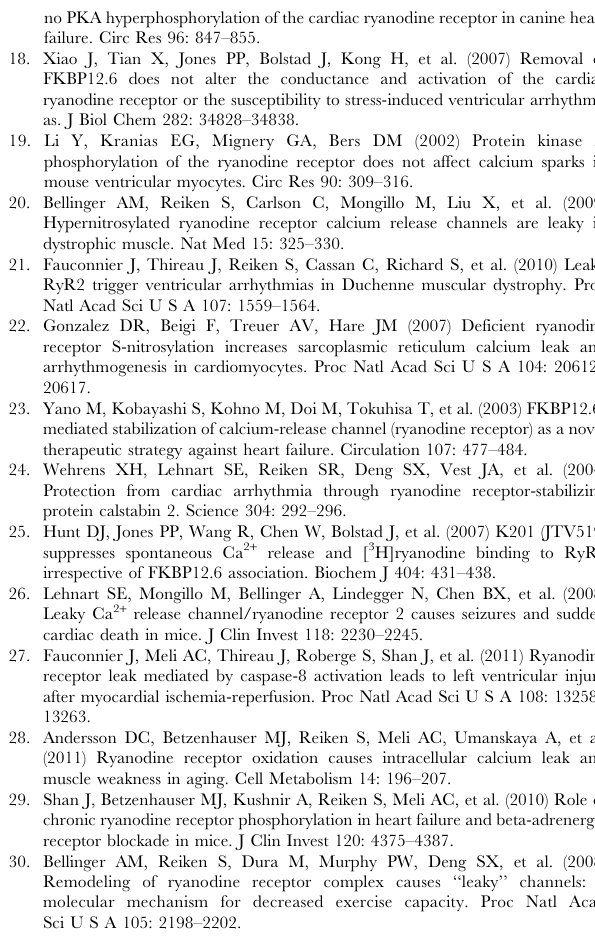
Figure S4 Effects of FKBP12 and S107 on [ 3 H]ryanodine binding to SR vesicles not treated and treated with FK506. (A) Time course of specific [ 3 H]ryanodine binding.